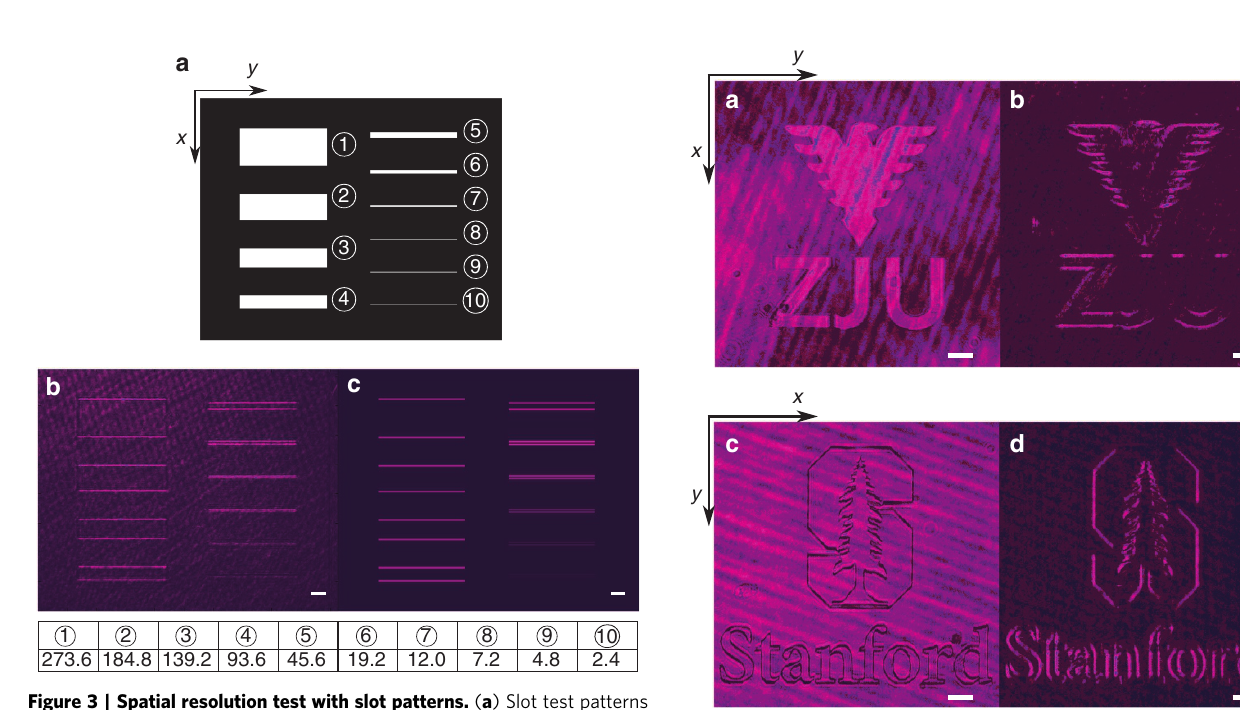
Figure 2 | Spatial differentiation demonstration for the beams through slits. ( a ) Incident field intensity generated by an adjustable slit. ( b ) Measured reflected intensity image corresponding to the incident field of a . ( c ) Normalized average intensity of the incident fields with three different slit widths of 321.65 m m (blue line), 504.20 m m (red line) and 738.70 m m (black line). ( d ) Experimental normalized average reflected intensity (solid lines) and theoretical differentiation results (dashed lines) for the three cases in c .